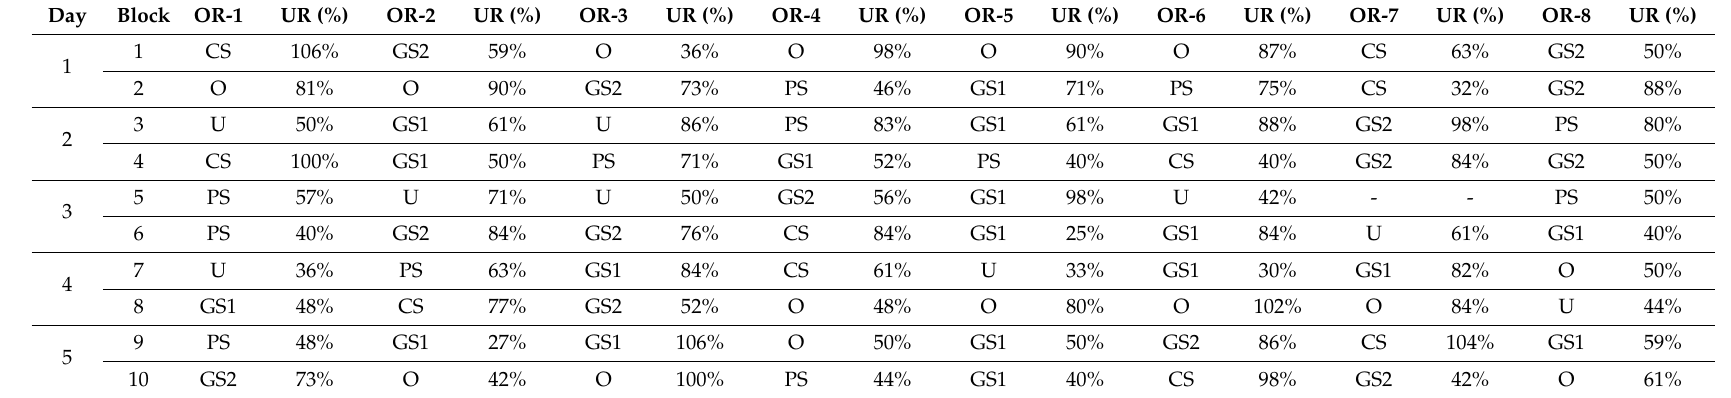
Table 5. Created schedule for Scenario 4 as a result of the constraint programming